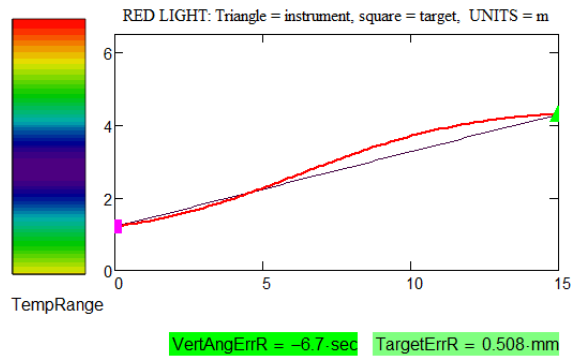
Figure 2 Example of simulated refraction in a layer model. The departure from a straight line is exaggerated for the purpose of illustration.